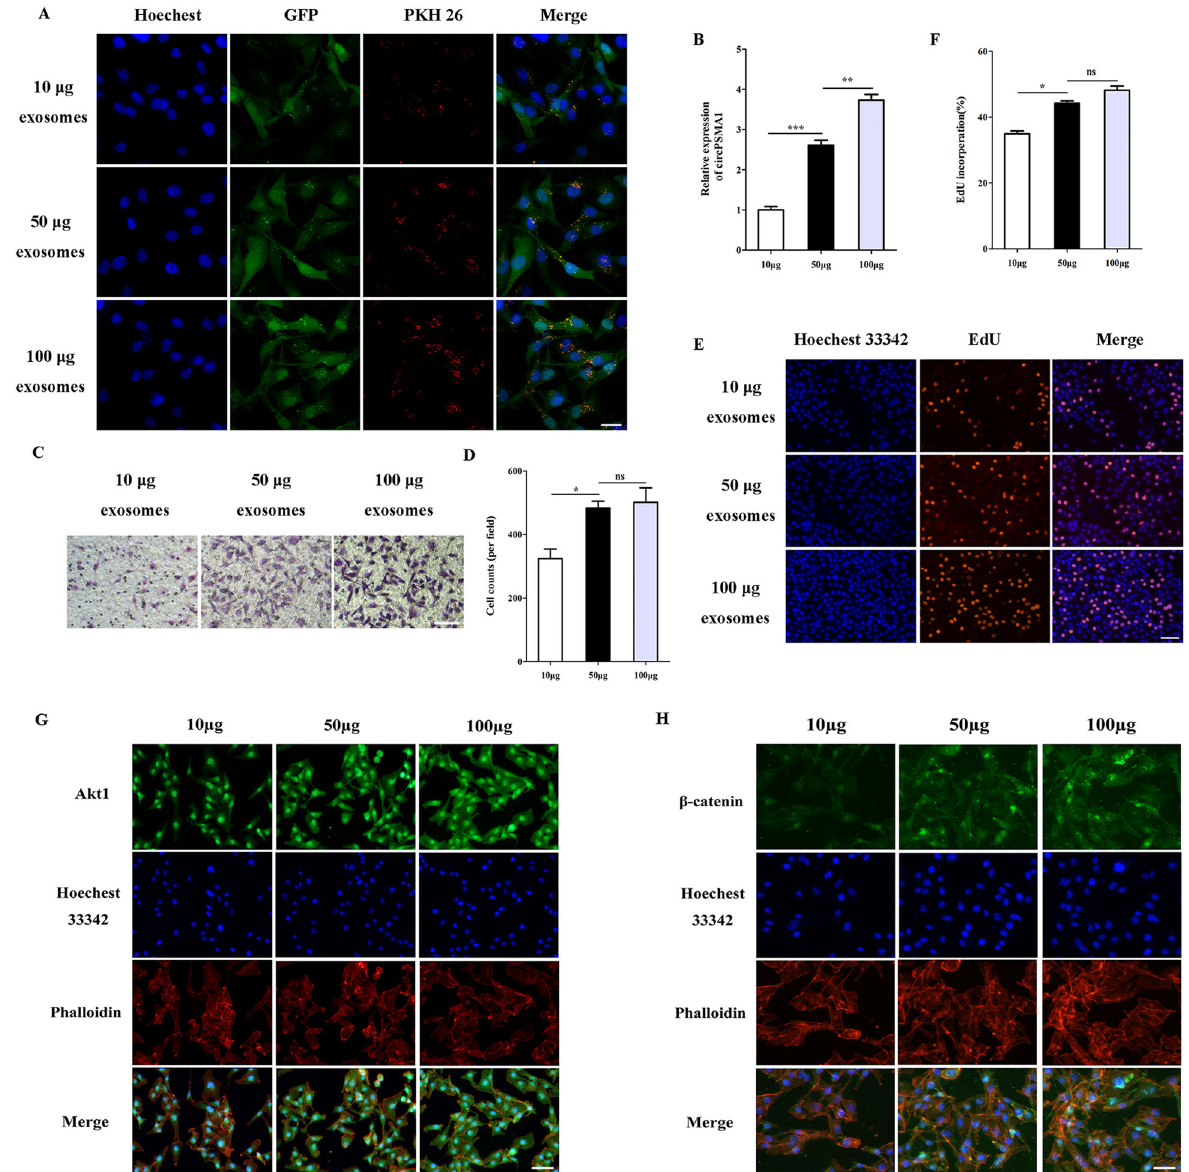
Fig. 7 Exosomes derived from TNBC cells can promote cell proliferation and migration through modulate the expression of circPSMA1/ Akt1/ β -catenin. A The exosome absorption by MDA-MB-231 cells was visualized by IF (magni fi cation, ×100, Scale bar, 50 μ m). B The circPSMA1 expression level of MDA-MB-231 cells treated with different concentrations of exosomes. C – D The migration abilities of MDA-MB-231 cells after treated with different concentrations of exosomes were detected by transwell assays (magni fi cation, ×100, Scale bar, 100 μ m). E – F The proliferative abilities of MDA- MB-231 cells after treated with different concentrations of exosomes were shown by EdU assays (magni fi cation, ×100, Scale bar, 100 μ m). B – H Protein levels of Akt1 and β -catenin after treated with different concentrations of exosomes in MDA-MB-231 cells were assessed by IF (magni fi cation, ×100, Scale bar, 50 μ m). Data were shown as mean ± SD, * p < 0.05, ** p < 0.01, *** p <